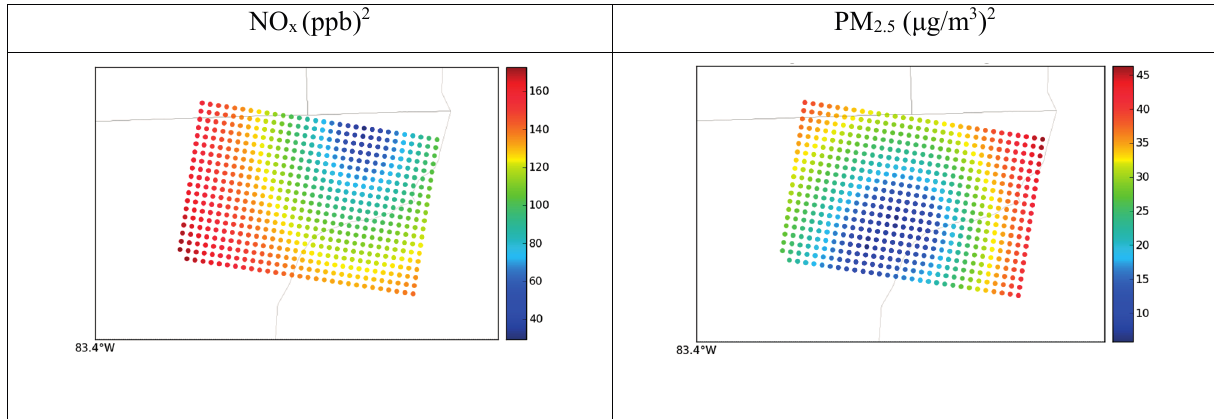
Figure 10. Spatial plots for the Detroit 30-km × 20-km grid showing annual averages of error variances from STOK as